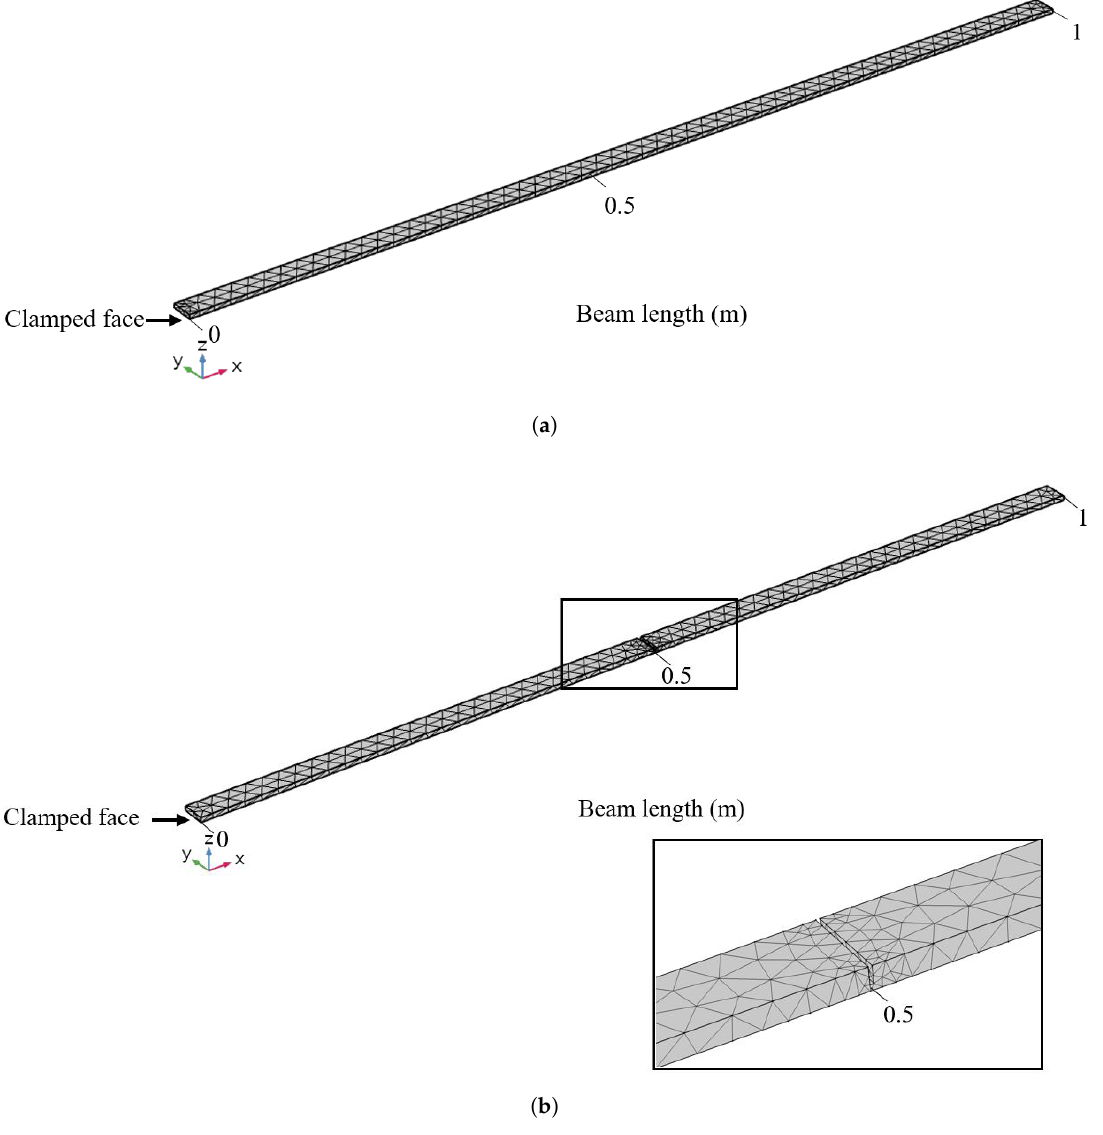
Figure 2. 3D FE mesh of the cantilever beam ( a ) healthy state ( b ) and example of damaged state with zoom in the damage